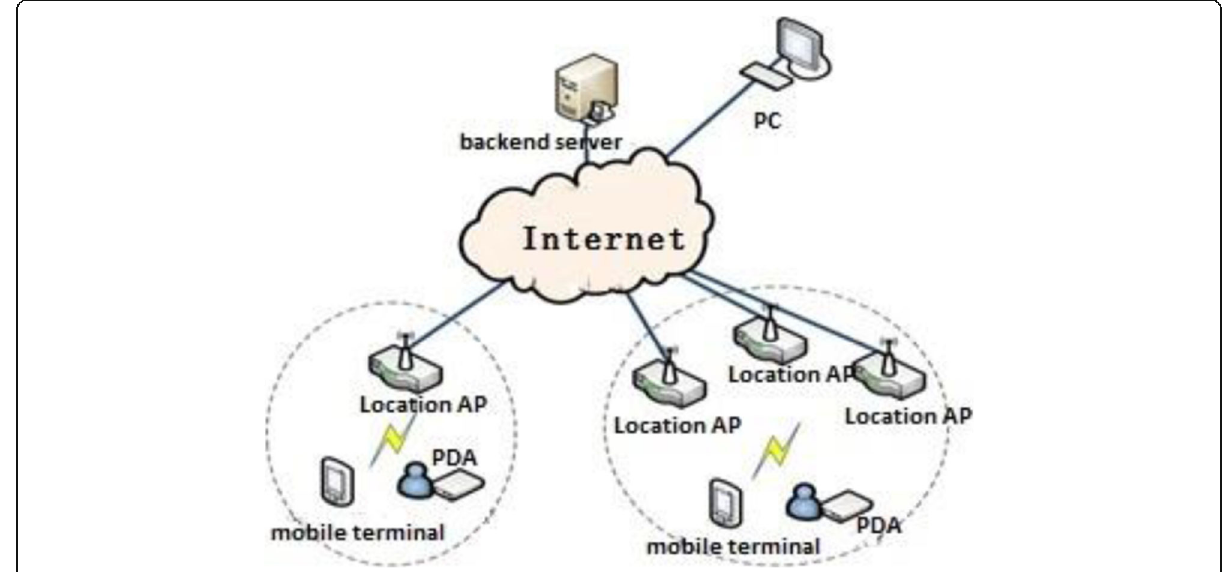
Fig. 1 Overall architecture of Wi-Fi